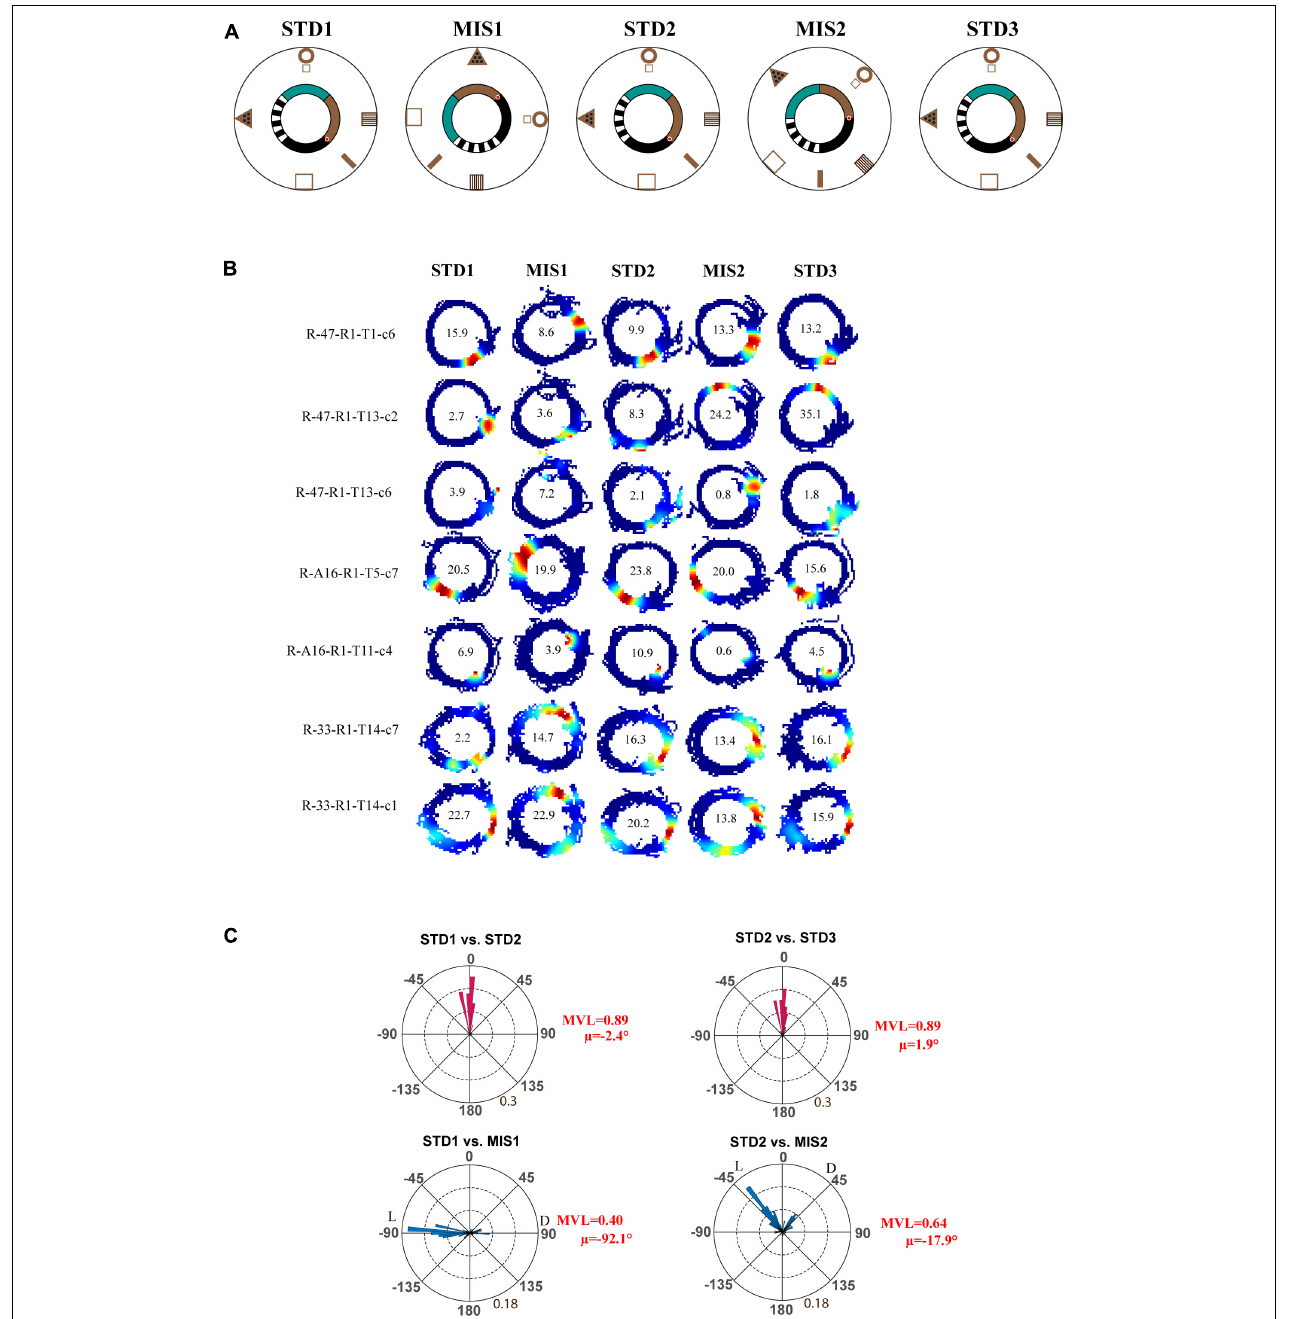
FIGURE 3 | Schematic representation of the double rotation experiments with a textured track and reward as local cues (Tex + Rwd). (A) The schematic representation of a double-rotation paradigm in which reward was provided at a particular location on the textured track. A white dot with the red center indicates the reward location. (B) Representative place fields from different experimental days from five sessions. The numbers inside the firing rate maps indicate the peak firing rate in Hz. The rate maps are color coded as described in Figure 2 . (C) Circular histogram shows place field rotation of hippocampal population across different standards and mismatch comparisons. The corresponding mean vector length (MVL) and mean direction ( µ ) of each comparison are shown alongside the plot. L and D indicate the rotation of local and distal cues.